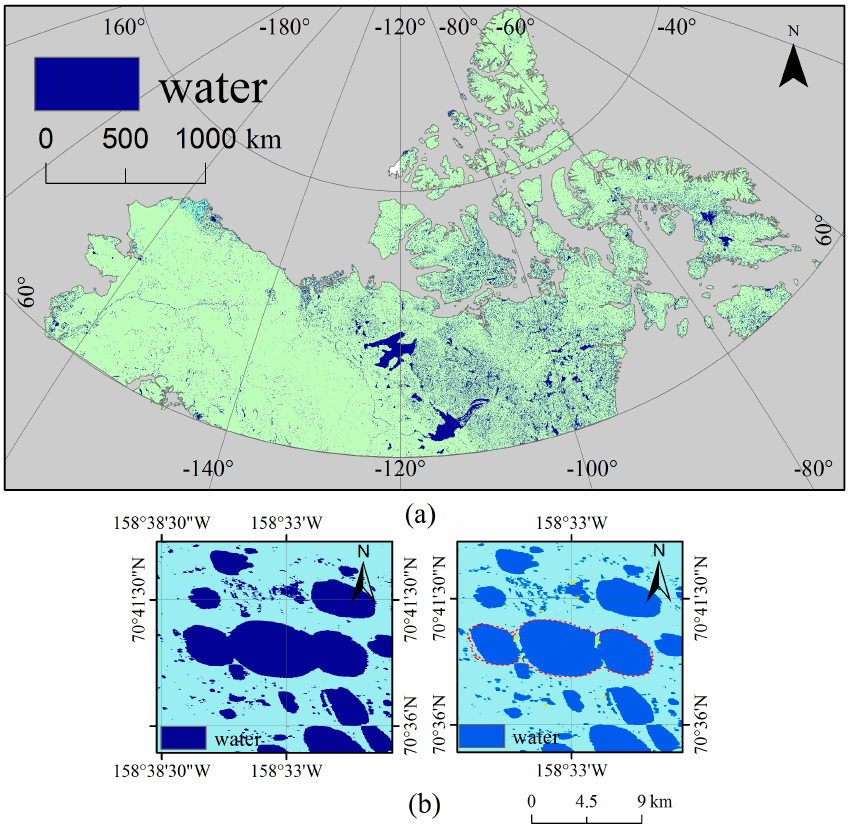
Figure 4. The maps showing ( a ) the distribution of inland water in the study area in 2016 and ( b ) a lake in the Barrow region in 2000 ( left ) and the lake in 2016 ( right ), showing a shrinkage over the 16-year period.